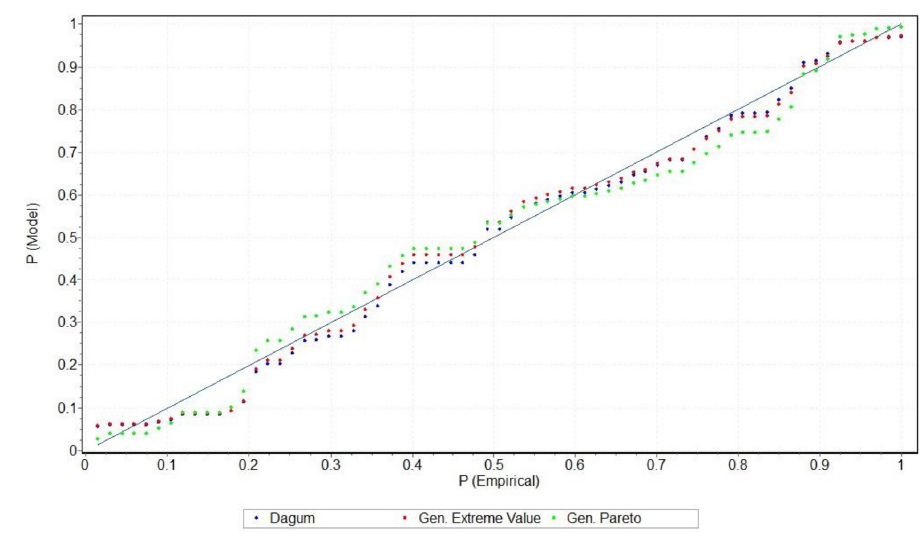
Figure 14. P-P plot comparing the fitted theoretical CDFs against the empirical CDF of corrosion rate in a sea environment related to the NiTi-1 alloy.